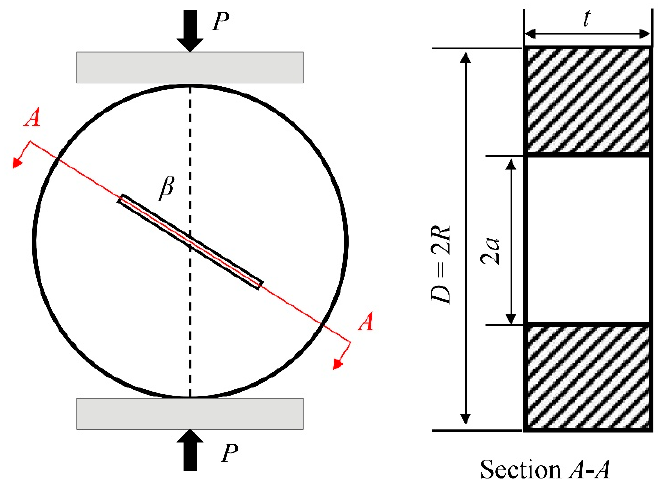
Figure 1. Diagram of a central cracked Brazilian disk (CCBD) specimen under compression.